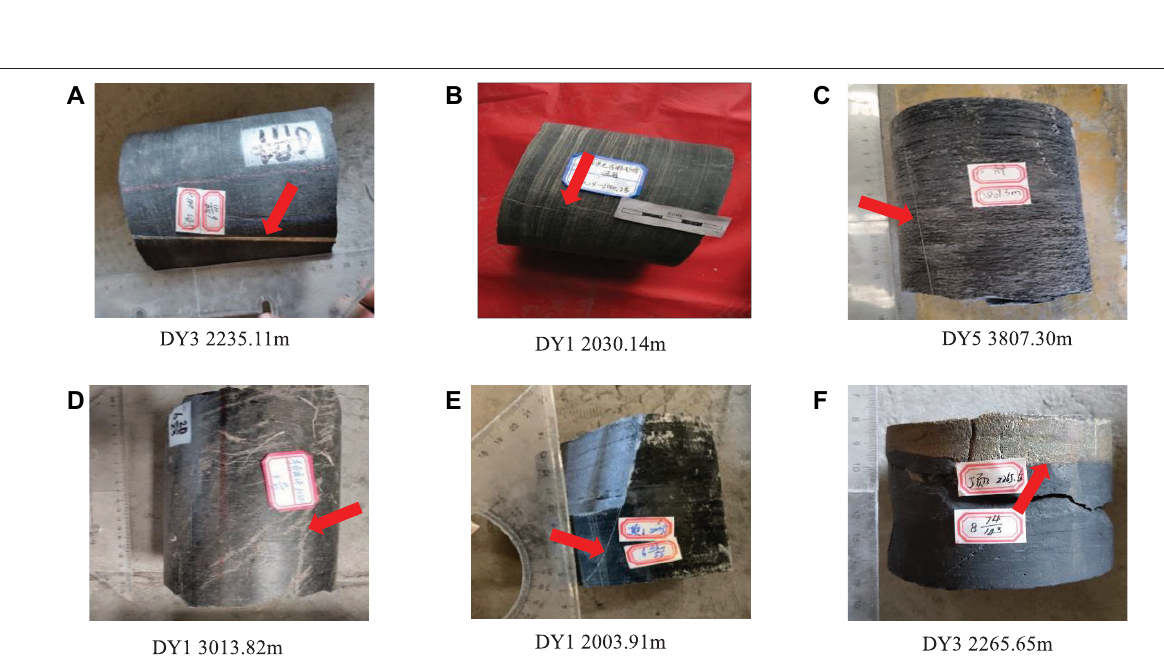
Frontiers in Earth Science |